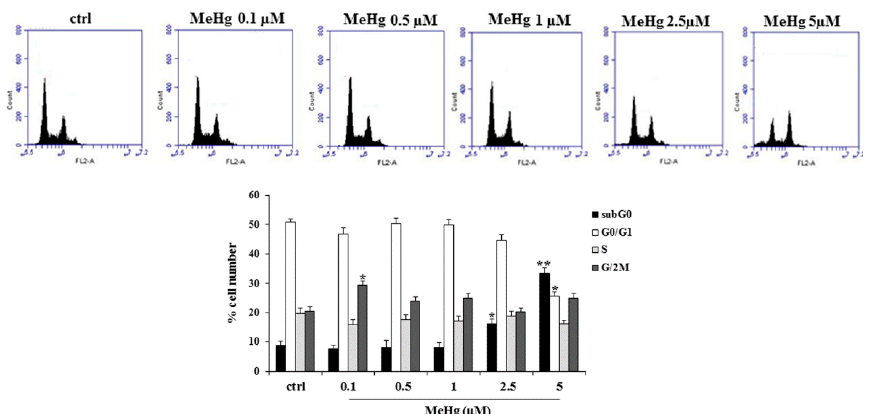
Figure 2. Effects of MeHg on cell cycle progression of Nthy-ori-3-1 cells. Cells were exposed for 24 h to the indicated concentrations of MeHg and analyzed by flow cytometry as described in Methods. Untreated cells were used as control (control). In upper panel, cytofluorimetric graphics of a representative experiment of three separate determinations are shown. Lower panel shows the distribution of cells in subG0, G0 / G1, S and G2 / M phases of the cellular cycle. The results represent the mean ± SD of three independent experiments. Statistical analysis was performed using the Tukey–Kramer multiple comparisons test. * p < 0.05, ** p < 0.01, vs. control. No e ff ect was detected on the production of reactive oxygen species (ROS) (Figure